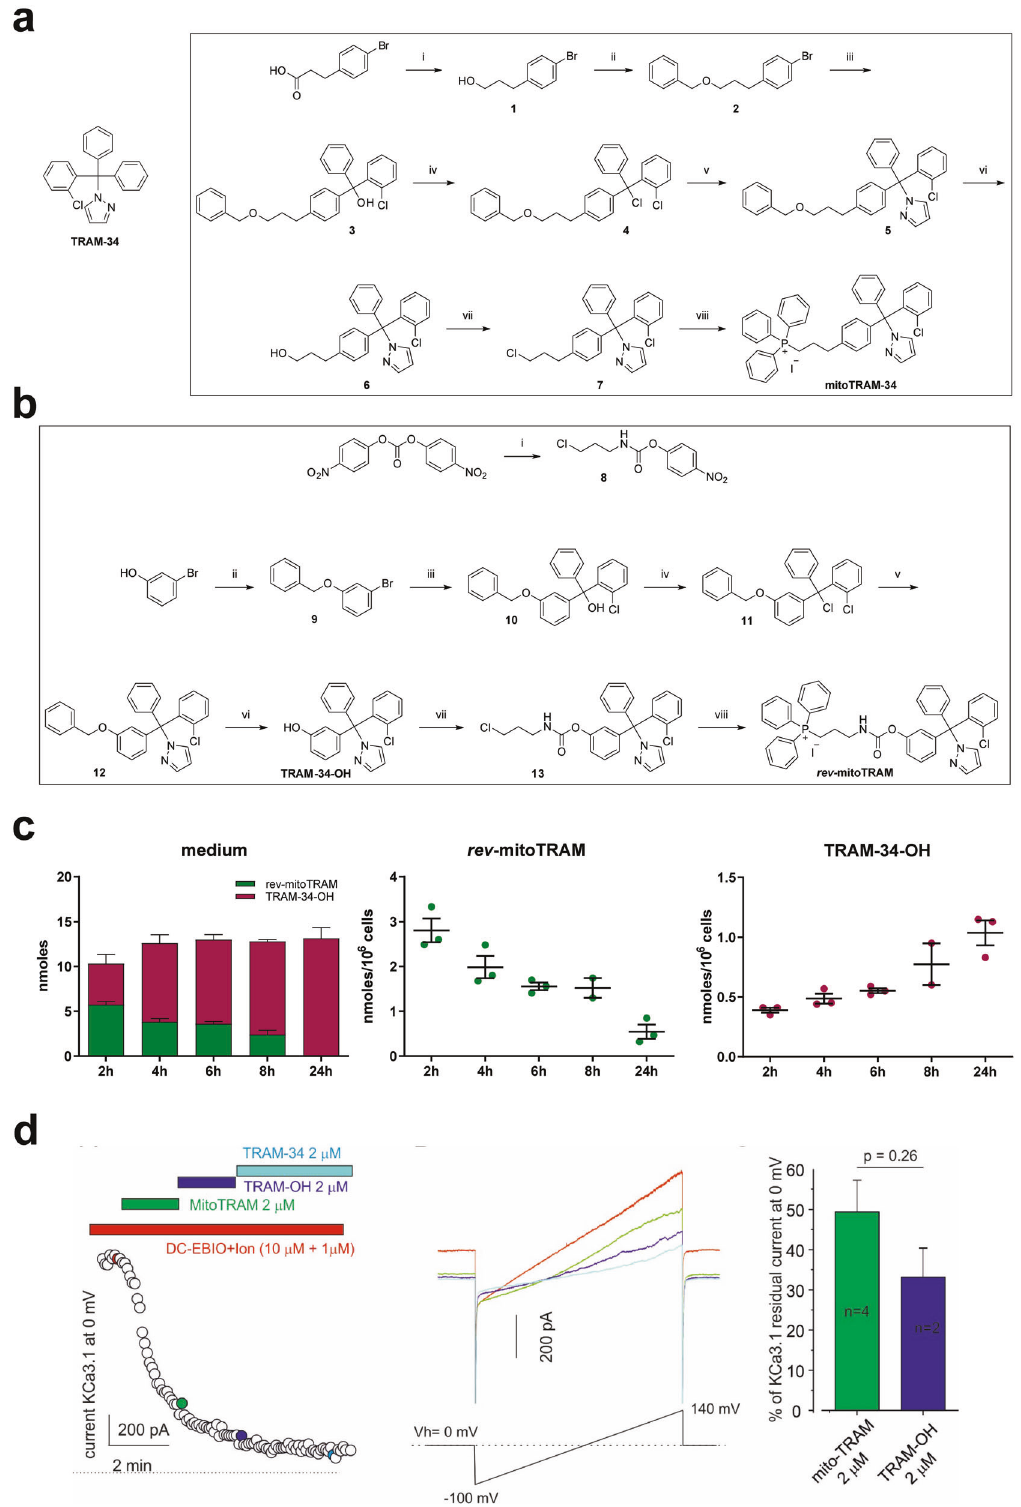
Permount ™ mounting medium (Fisher Chemicals) prior to imaging with a Zeiss Axio Observer wide fi eld microscope. For staining of lymph nodes, 10 µm cryosections were thawed for 30 min at room temperature, rehydrated for 30 min in PBS, permeabilized for 10 min in 0.1% Triton X-100 (Sigma-Aldrich) in PBS, washed 3x